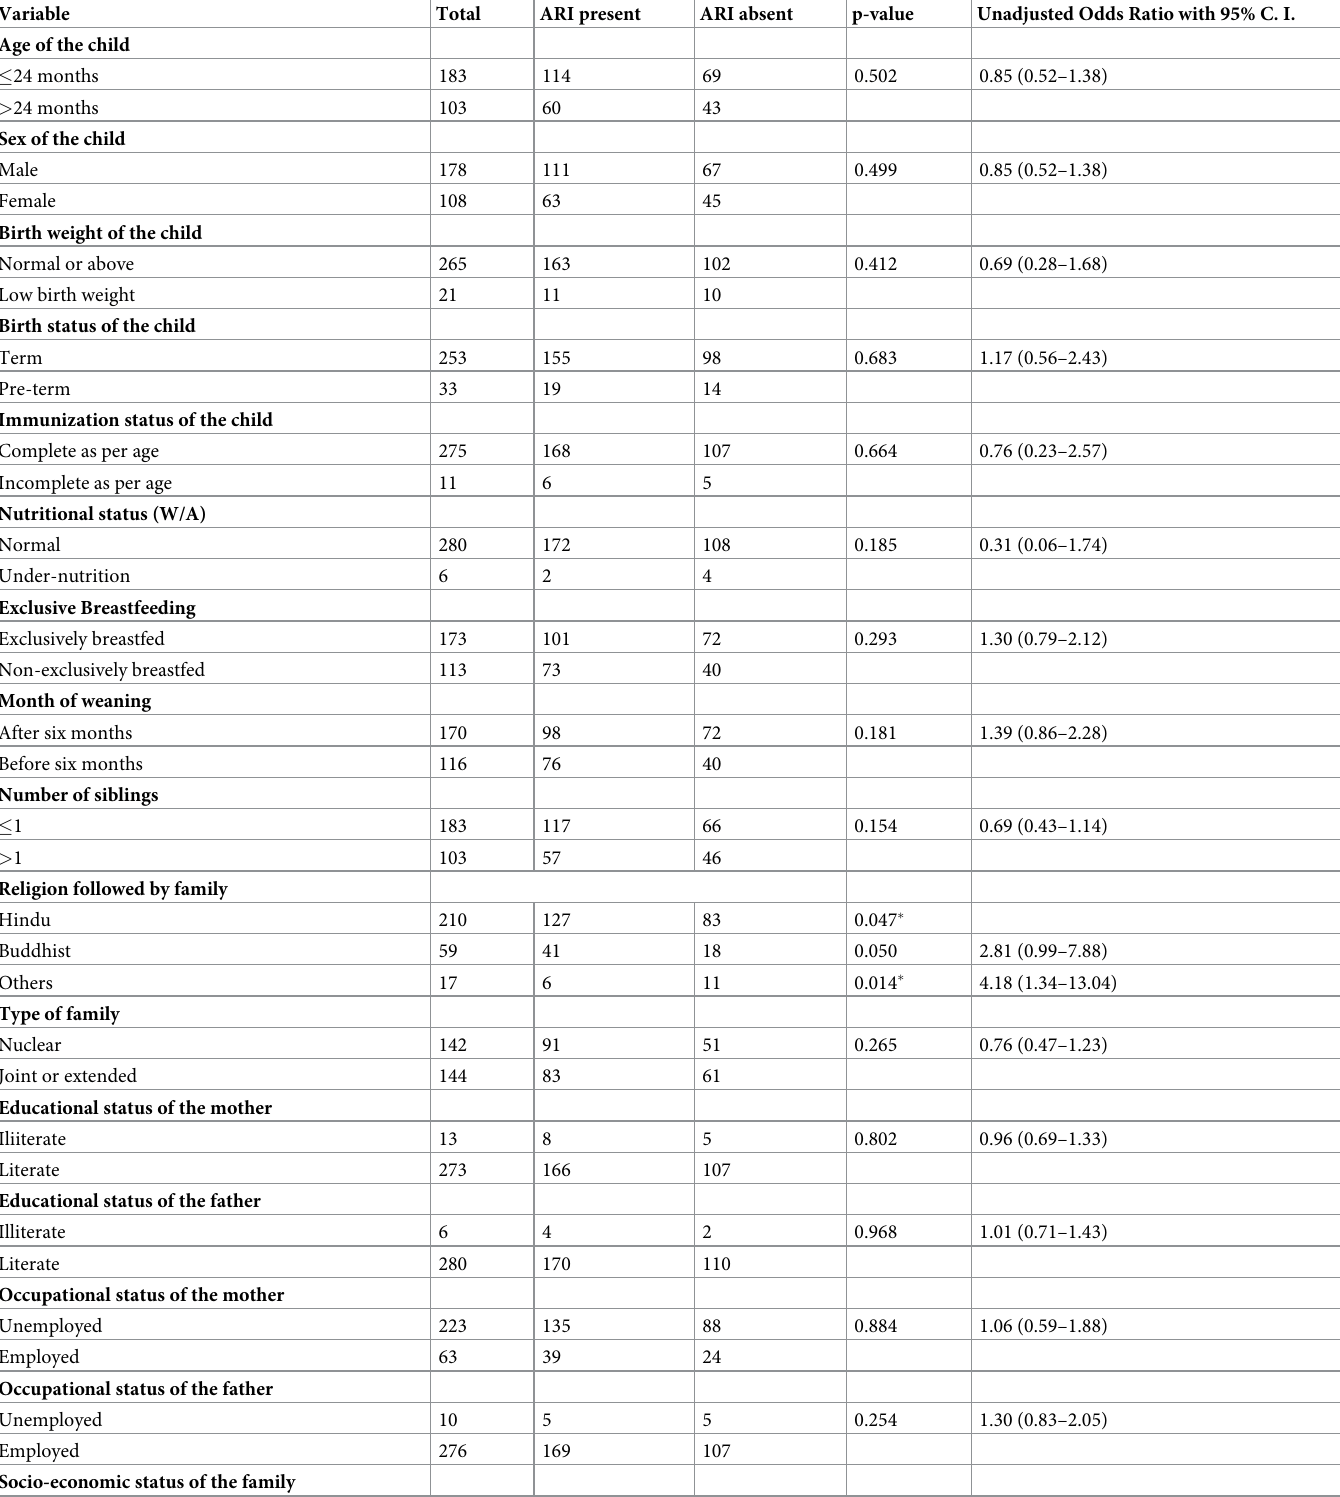
Table 2. Bivariate analysis of the factors associated with ARI. n =